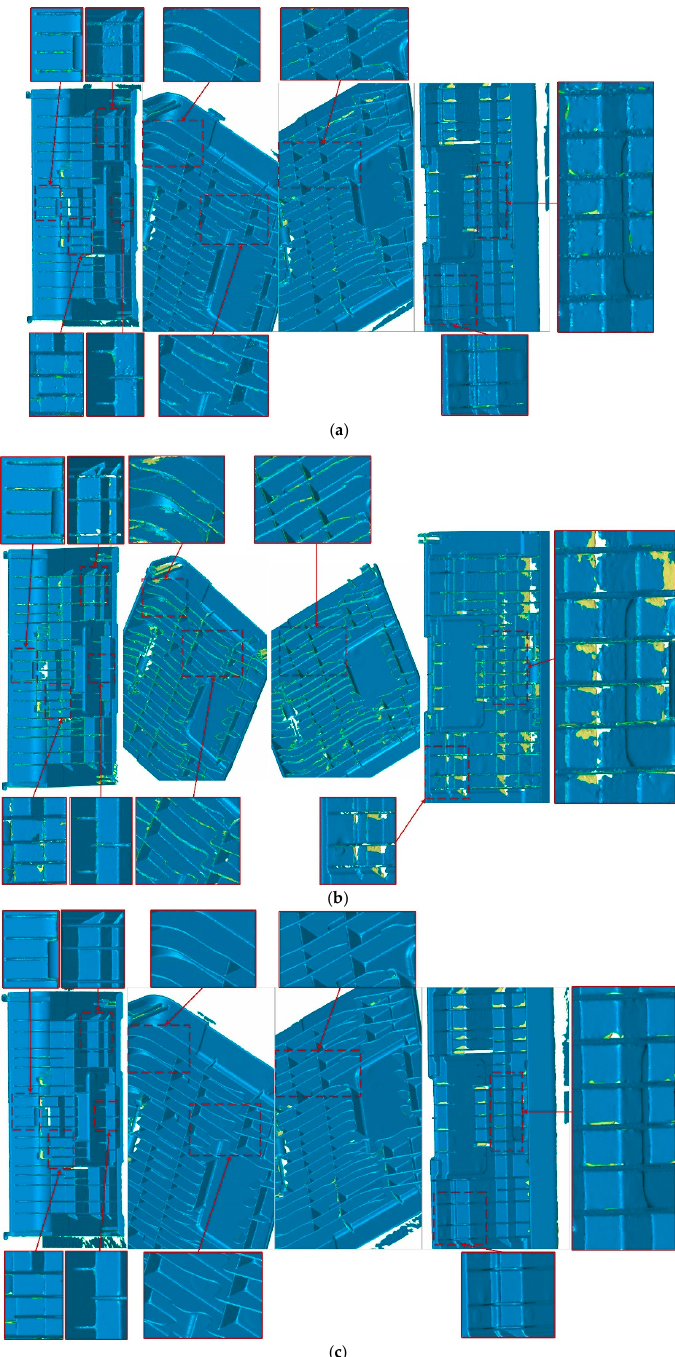
Figure 17. Comparison of the plastic shell model; ( a ) the interference of TSDF brings holes and spikes on the stiffener of the model; ( b ) Creaform’s [7] results show similar problems; ( c ) the proposed post-processing approach repaired the surface of the stiffener.